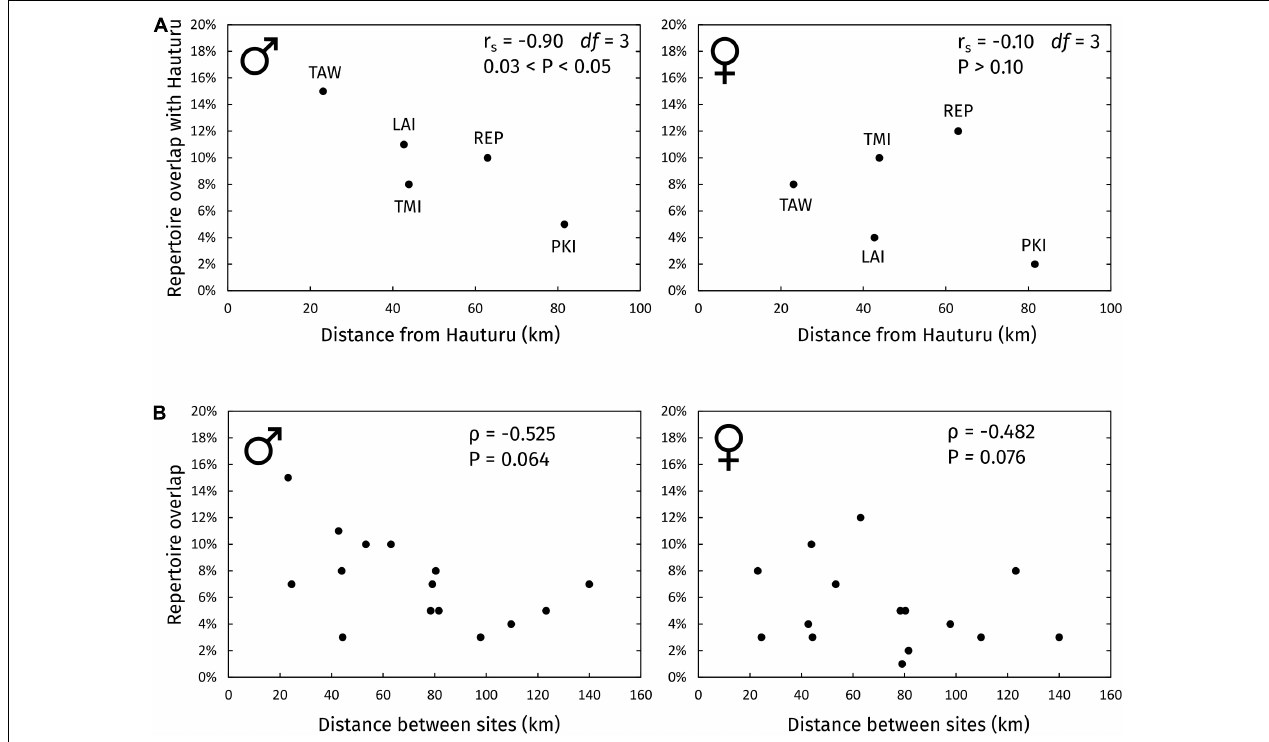
FIGURE 5 | Repertoire overlap vs. distance between sites. (A) Repertoire overlap of all subpopulations with Hauturu vs. their distance from Hauturu. Overlaps were calculated on repertoire lists of types with 3+ occurrences within each site-and-sex group. Site abbreviations: TAW, Tawharanui; LAI, Lady Alice Island (representing Hen and Chickens); TMI, Tiri; REP, Repanga; PKI, Tawhiti Rahi (representing Poor Knights Islands). (B) Site-site repertoire overlap vs. site-site geographic distance, for all pairs of sites. Spearman’s rank correlation coefficients (r s ) were calculated using the RELATE routine in PRIMER (version 7) with 9,999 permutations, accounting for the non-independence of